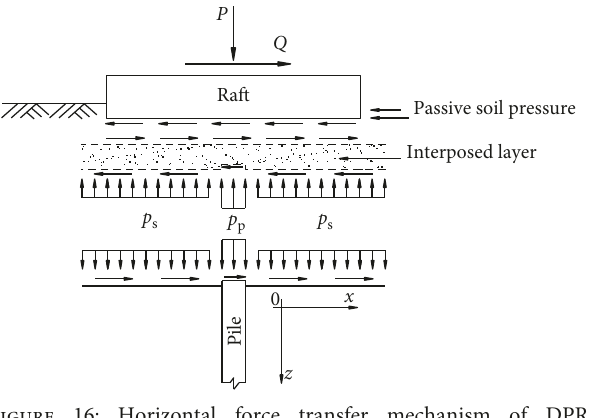
Figure 16: Horizontal force transfer mechanism of DPR foundations.